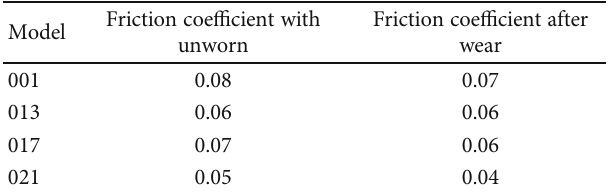
Figure 18: Friction coe ffi cient curve of each fi nger lock after worn. Table 5: The change of friction coe ffi cient of the fi nger lock in